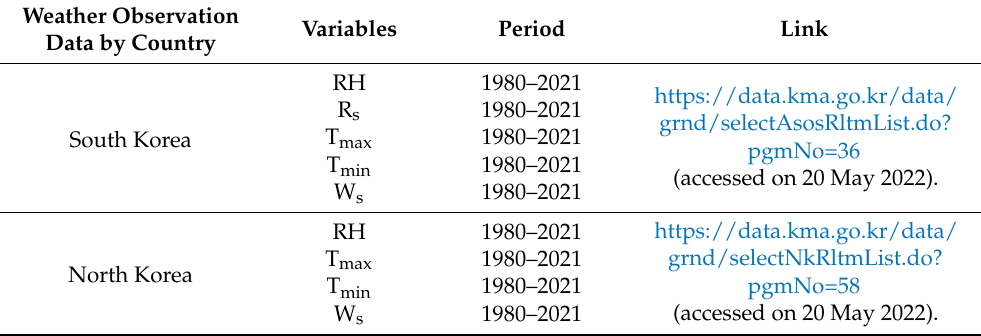
Table 1. The list of the extracted data for this study. Weather Observation Variables Data by Country